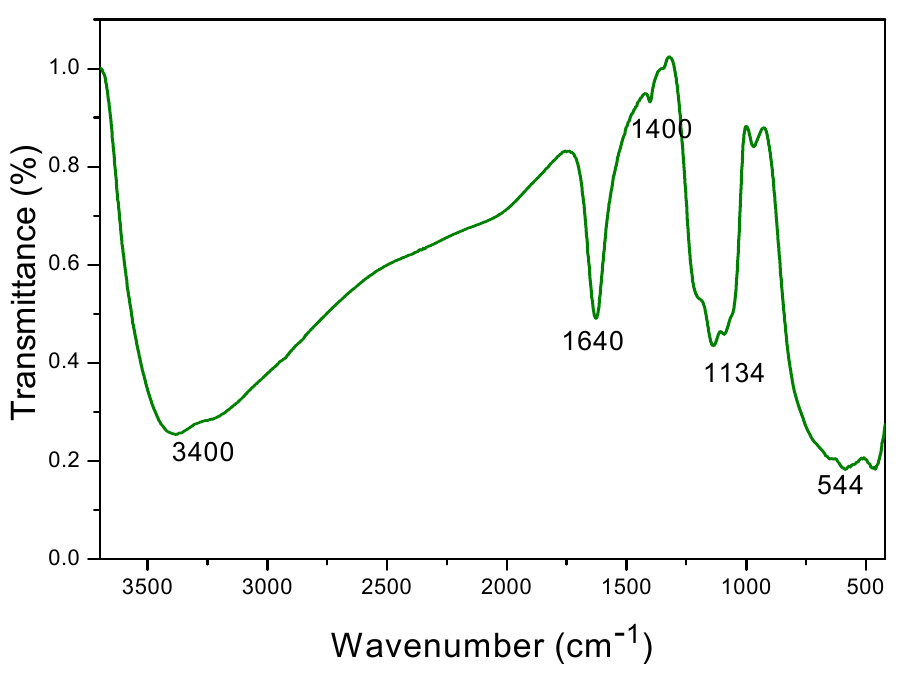
Figure 4. FTIR Spectrum of TiO 2 nanoparticles. The UV/visible spectrum of TiO 2 nanoparticles (Figure 5) exhibitedanabsorption band at 210 nm, indicating the presence of ionic liquid. The absorbance at 270 nm is attributed to the presence of titanium dioxide. This peak shows a blue shift compared to bulk titanium dioxide due to the size effect [30]. Theweak absorption at 500 nm is due to the presence of V-type centers in TiO 2 , which are created dueto the trapping of holes of the TiO 2 in the cationic vacancies of the material [31].